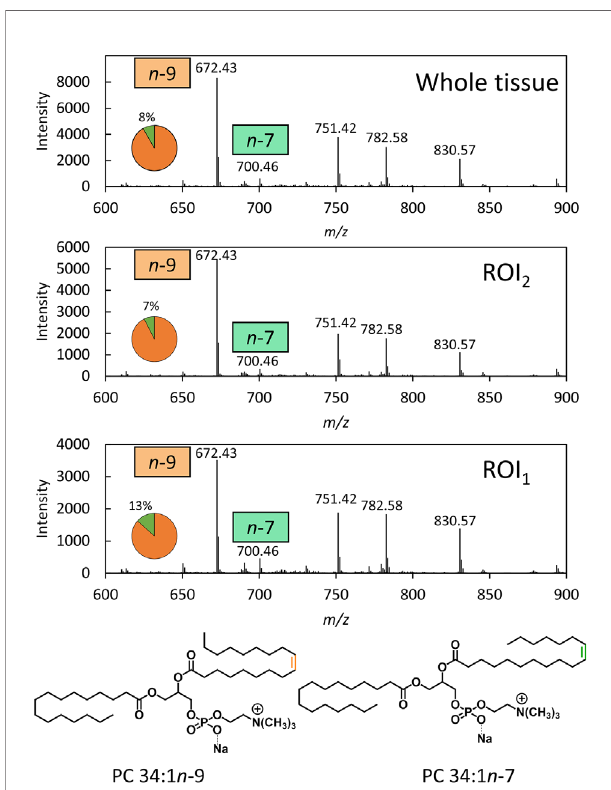
FIGURE 1 | OzID mass spectra averaged across a whole prostate tissue sample (32500 pixels) and 2 individual regions across the tissue (300 pixels each). OzID mass spectra obtained from averaging over: (Top) the whole tissue section; and (Mid/Bottom) ROIs indicated in Figure 2 . Peaks corresponding to OzID ions indicative of PC 34:1 n- 7 and PC 34:1 n- 9 are displayed as a fraction of total signature ions in the pie charts. Data were obtained using a modi fi ed Waters SYNAPT G2Si (operating at a mass resolving power of ˜ 15,000) . The precursor ion ( m/z 782) was isolated using a 1 Th. isolation window, and OzID took place during transit of the mobility cell (15 ms). See Figure S9 for an OzID fragmentation scheme and look up table for spectral